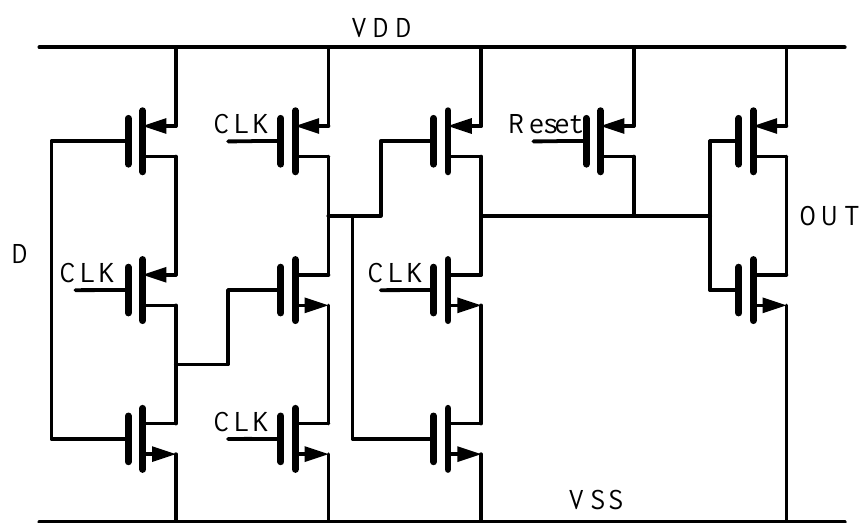
Figure 12. The schematic of the TSPC.